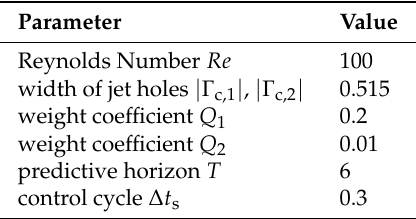
Table 1. Parameters for the controlled system and the model predictive